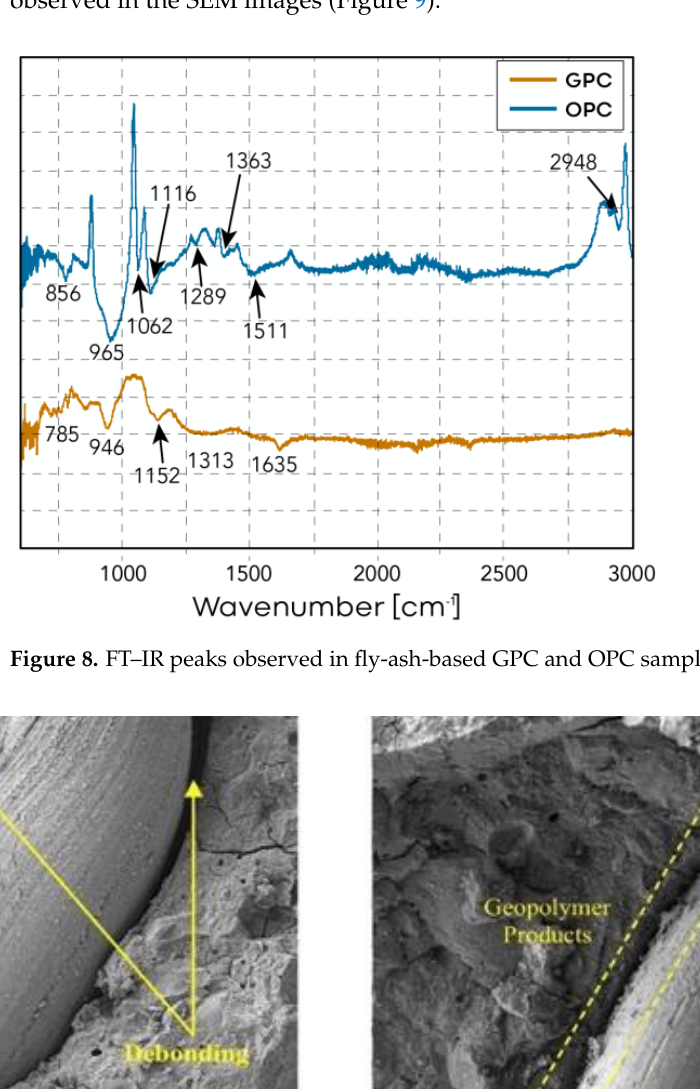
Figure 10. SEM image of ( a ) MSWI-FA and ( b ) FNS [55]. 4.3. Brunauer–Emmett–Teller (BET) Method Brunaeur–Emmett–Teller or BET method is used to determine the surface area (m 2 g −1 ) of materials to correlate the surface area to the mechanical and chemical properties of the materials [56]. Güngör and Ö zen [56] concluded that the higher the surface area, the greater the positive effect on the compressive strength of the geopolymer mortars because geopolymerization is more effective for smaller particles. Wang et al. [57] determined the surface area of the raw materials they used and the resulting geopolymers made of coal gangue and red mud. The researchers observed that there is enhanced adsorption for sam- ples with a large surface area and that geopolymerization and the incorporation of red mud Na 2 SiO 3 as an activator increase the surface area [11]. However, in the study by Freire